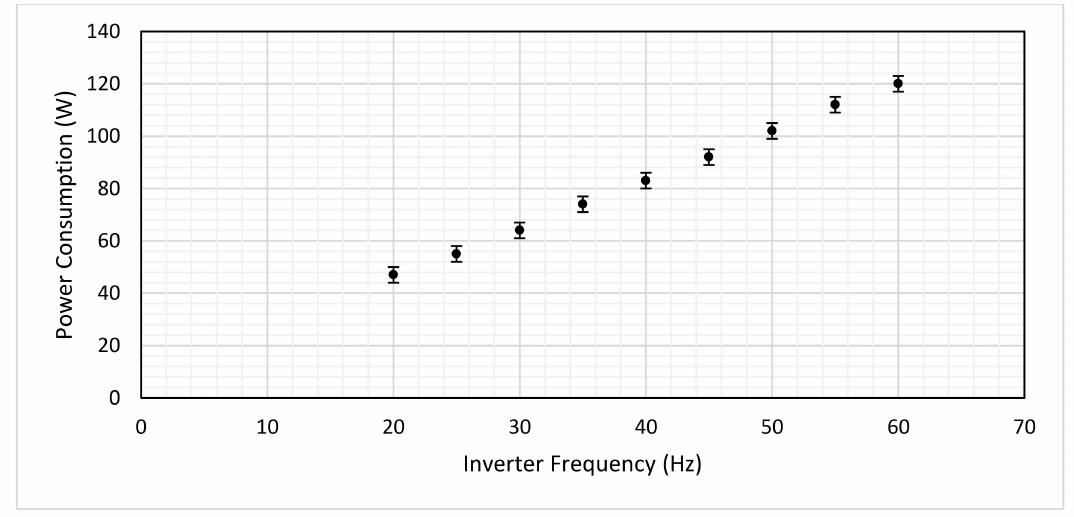
Figure 5. Pump power consumption with varying inverter